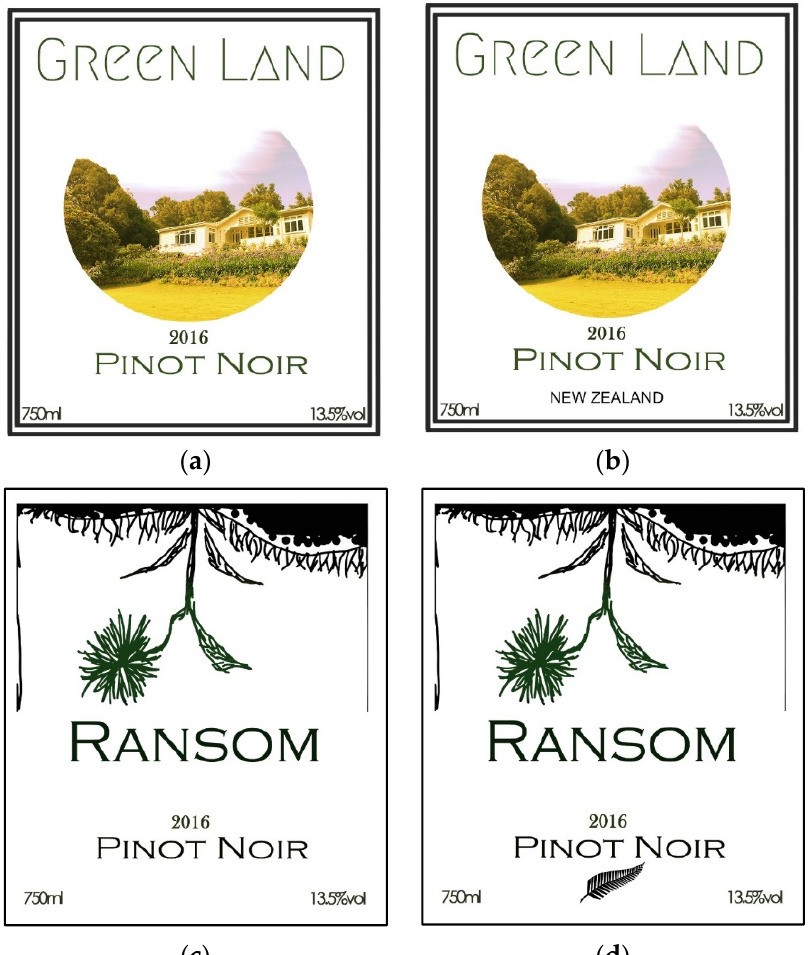
Area of Interest COO Information Figure 1. Wine label types with and without provenance emblem (New Zealand and ) used Script